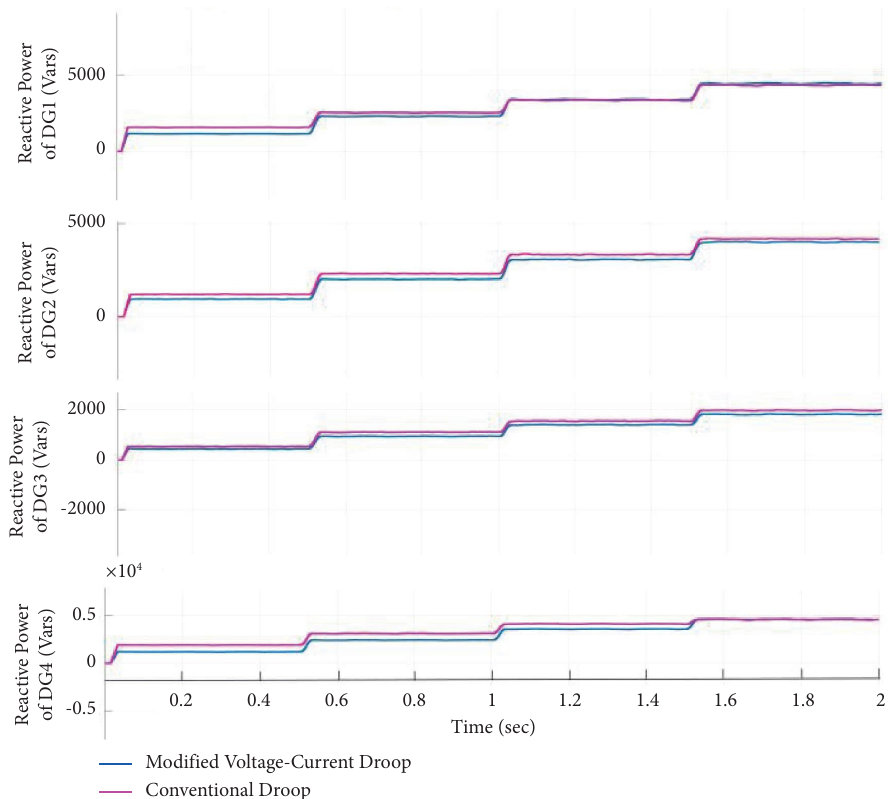
Figure 18: Reactive power injection by various DG in 9 bus microgrid test system.